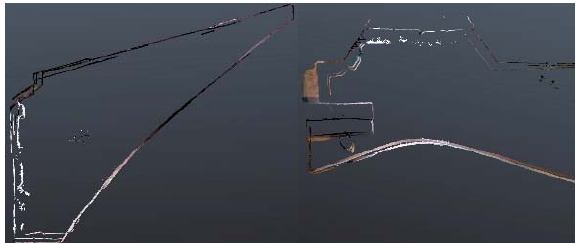
Figure 11. Misalignment of DOT DPI 8 scans. Section (left), plan (right).